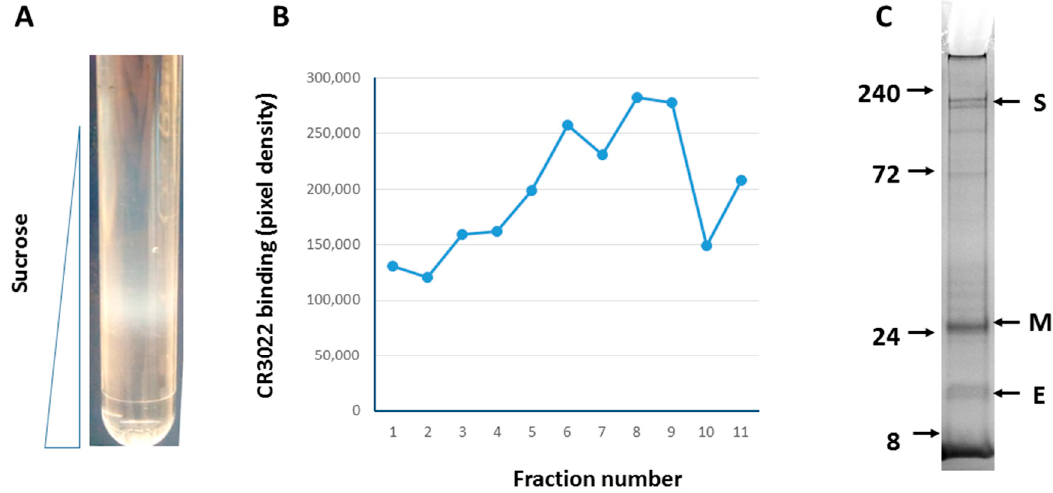
Figure 3. Purification of SARS-CoV-2 VLPs from infected Tnao 38 cells. Infected cultures were processed as described and the resulting gradient ( A ) fractionated from the top. Each fraction was bot blotted to nitrocellulose, incubated with human anti-S monoclonal antibody CR3022 and developed with an anti-human HRP conjugate. The blot was scanned and the dot intensity recorded and plotted against fraction number ( B ). The peak fractions (#8 & #9) judged by appearance and immunoreactivity was analyzed by SDS-PAGE and stained with Coomassie brilliant blue R250, which showed the presence all three VLP proteins, S, M and E ( C ).